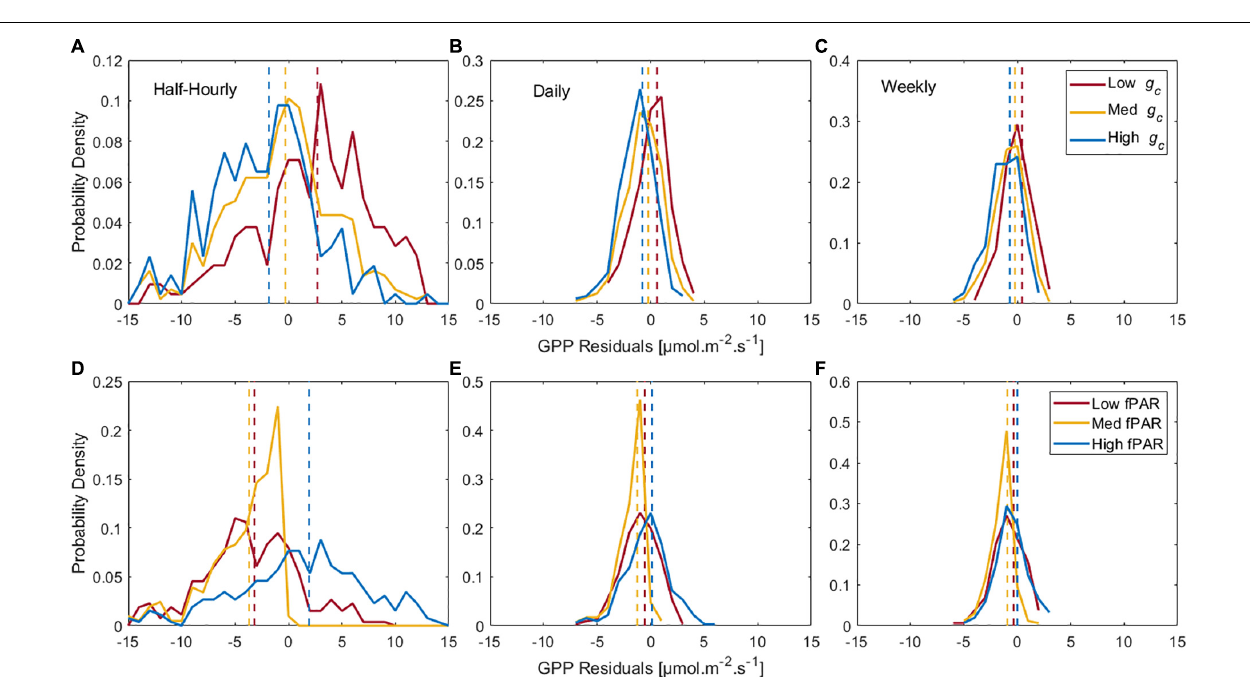
FIGURE 4 | Linear mixed effect model fit based on SIF data for (A) Half-Hourly, (B) Daily, and (C) Weekly timescales. The x -ax i s show the observed GPP, i.e., half-hourly EC GPP for (A) , mean daily GPP for (B), and mean weekly GPP for (C) . The y -ax i s show GPP values predicted by the LME model. The black line represents the 1:1 line.